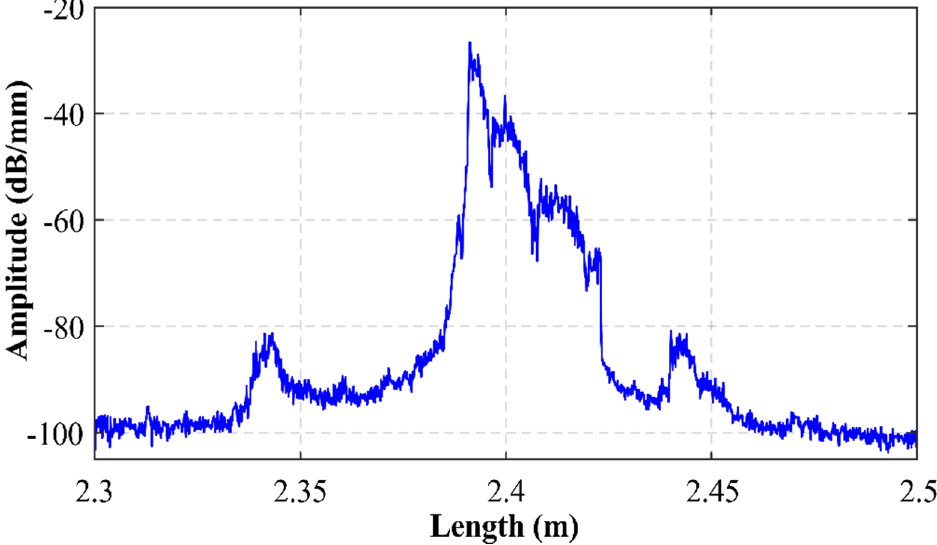
Figure 2. Backscattered optical power as a function of fiber length.